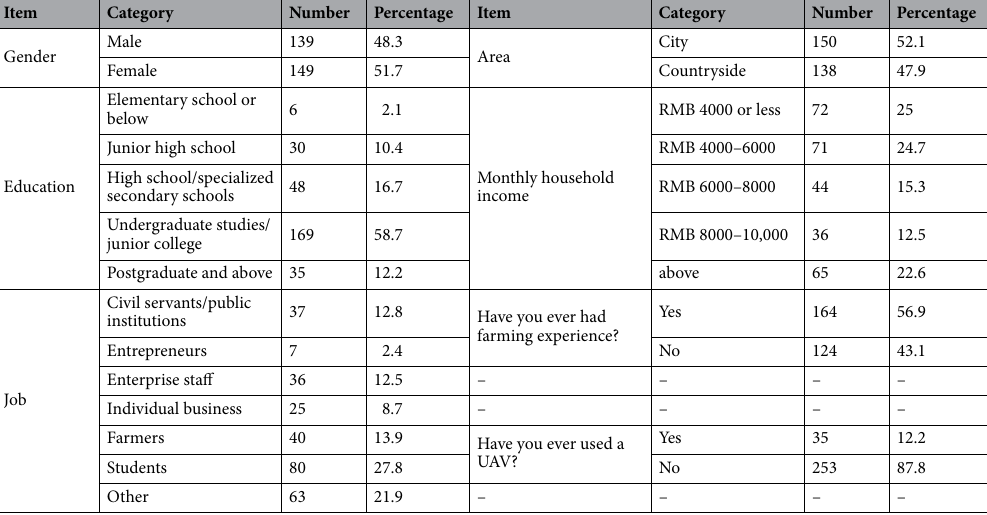
Table 2. Sample characteristics (N = 288). (1) The ratio of males to females in the sample is 1:1.07, which is balanced. (2) The educational level structure of the interviewees was reasonable, with 2.1%